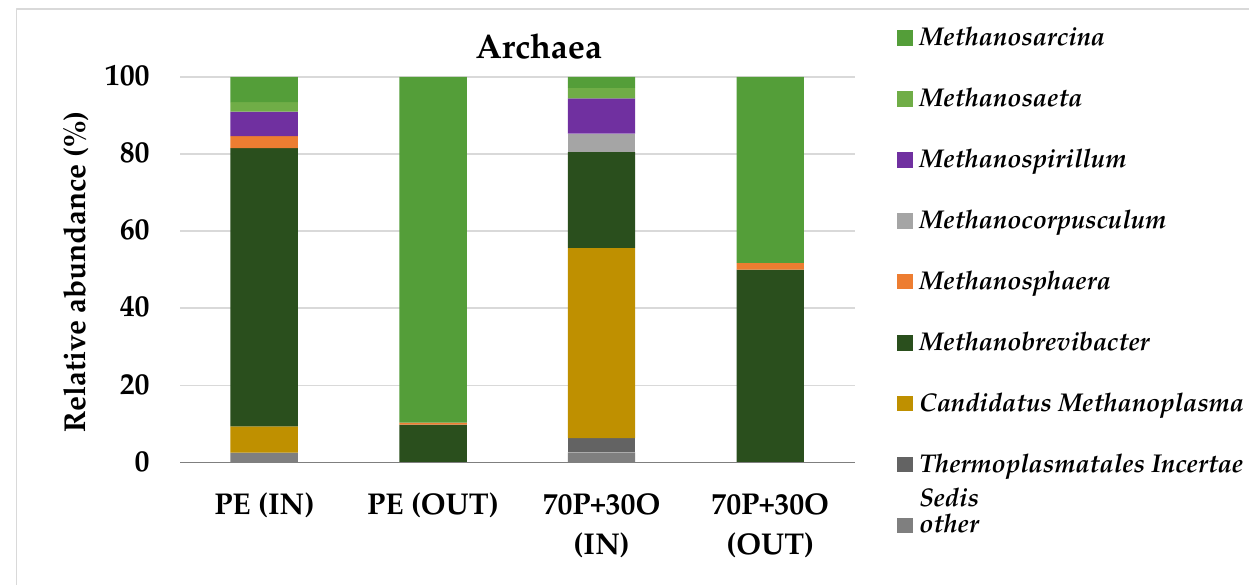
Figure 5. Relative abundance of Archaea genera. Other genera were not considered in this discussion due to their low presence (0.79–1.77%) in samples: Methanogenium ; unidentified